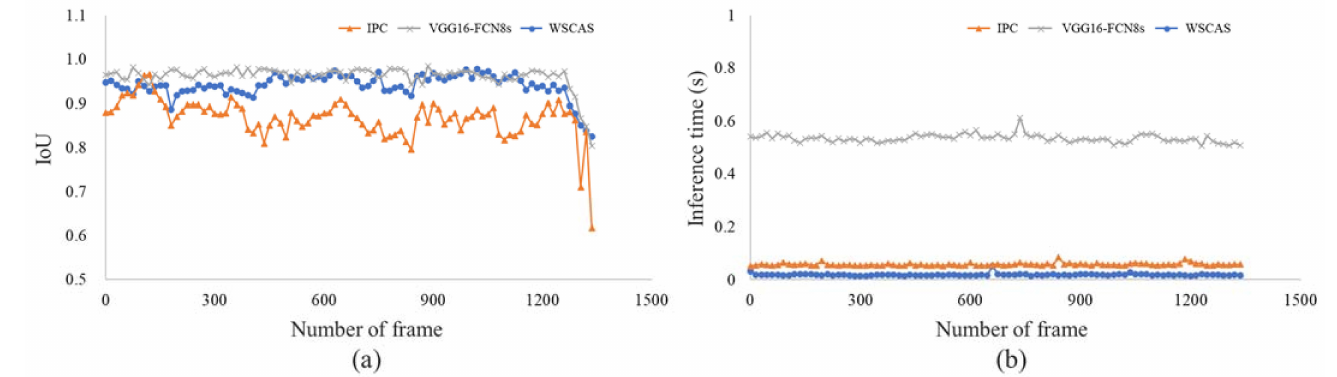
Figure 6. Localization performance ( a ) and inference time ( b ) comparisons by the segmentation